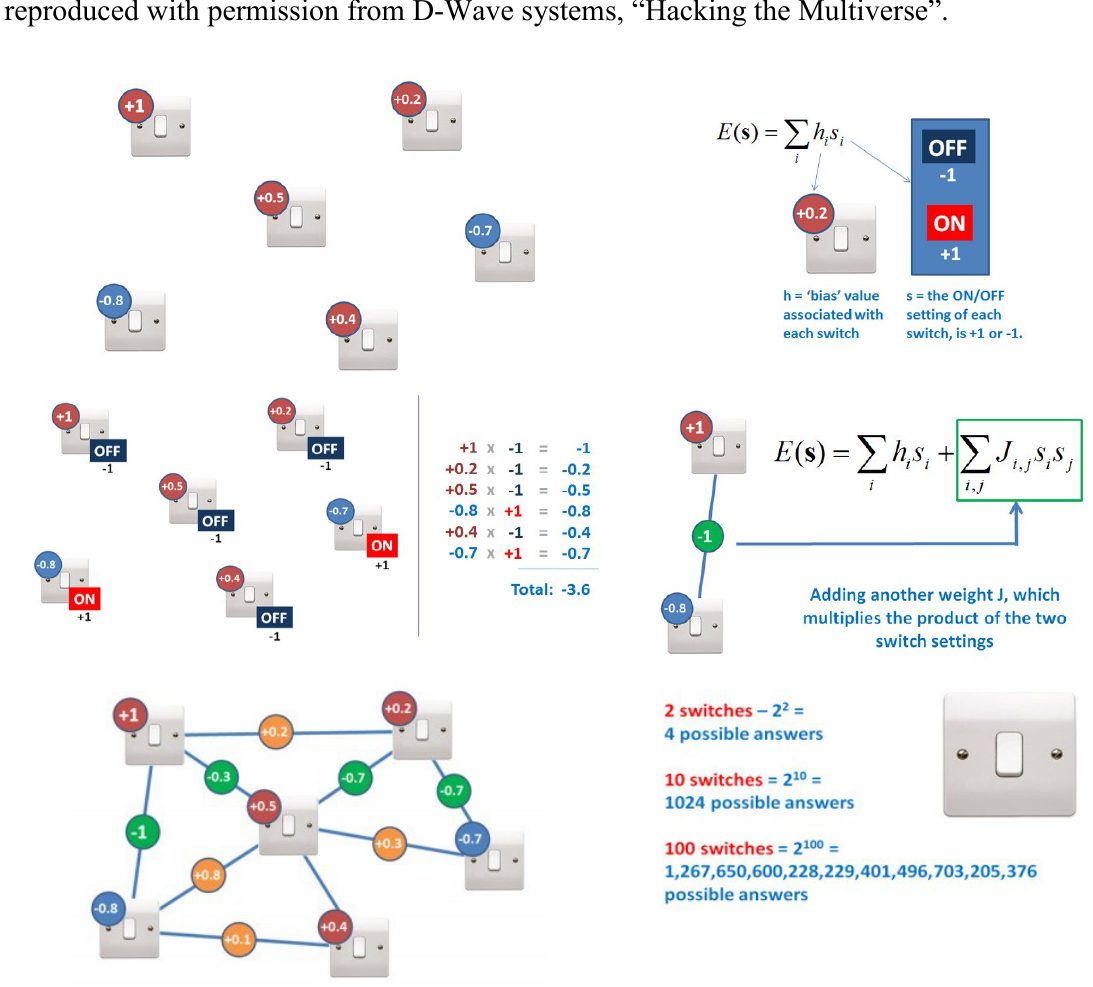
Figure 5. Optimization Algorithms, Interactions and Exponential Computations. An optimization problem is posed when a number of variables, e.g., SNPs, in aggregate account for an outcome such as a disease or drug response. An example of such variables shown below demonstrates this in the context of binary light switches, each with an independent weighted influence (top left). The sum of their influence on the outcome is calculated using the equation (top right) and summed in a linear fashion (middle left), in a relatively simple calculation. In the discovery phase, these weightings would not be known and would be discovered iteratively, with high computational needs. If, however, the factors interact in a network (middle right) a far higher number of permutations exists. The number of permutations is an exponential function of the number of variables and requires exponential computations (bottom left and right) for each added variable. A number of potential solutions exist for a given minimal dataset, within which the optimization algorithm attempts to find the best solution. Quantum computers, such as D-Wave systems [48], are ideally suited for the exponential computations required for optimization algorithms and are anticipated to be revolutionary for medical diagnostics and imaging [49]. Graphic reproduced with permission from D-Wave systems, ―Hacking the